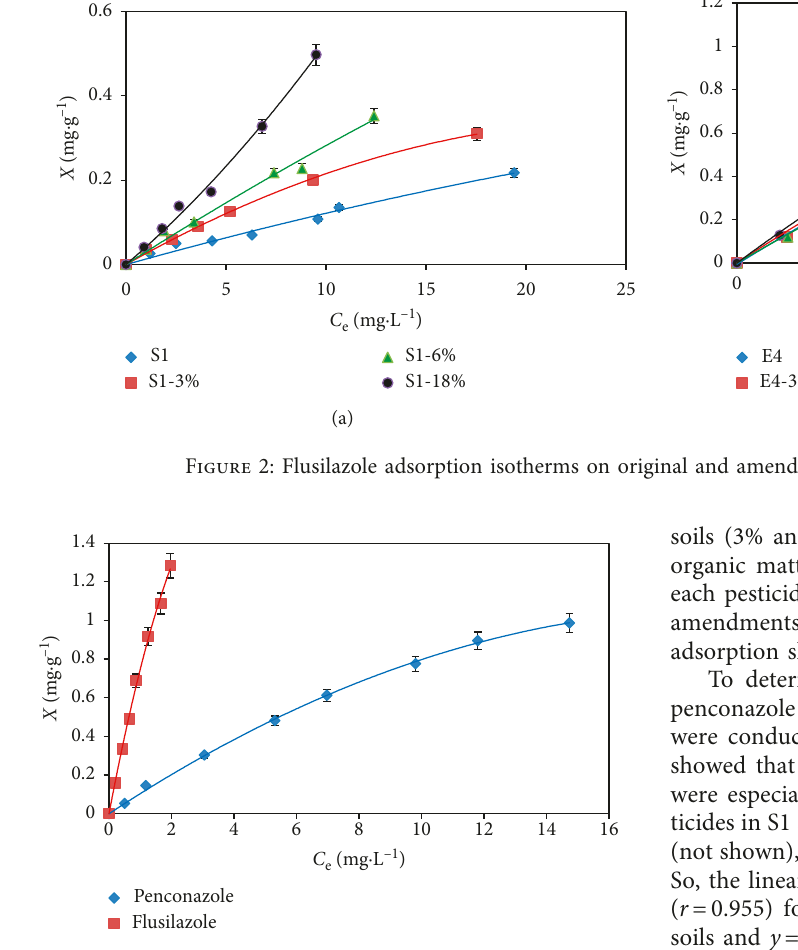
Figure 3: Adsorption isotherms of penconazole and flusilazole in